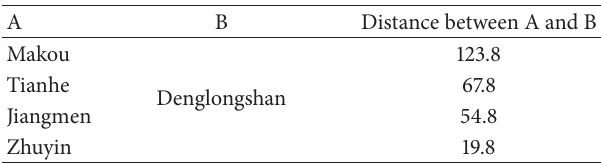
Table 9: Distance among stations in West River Delta (units: